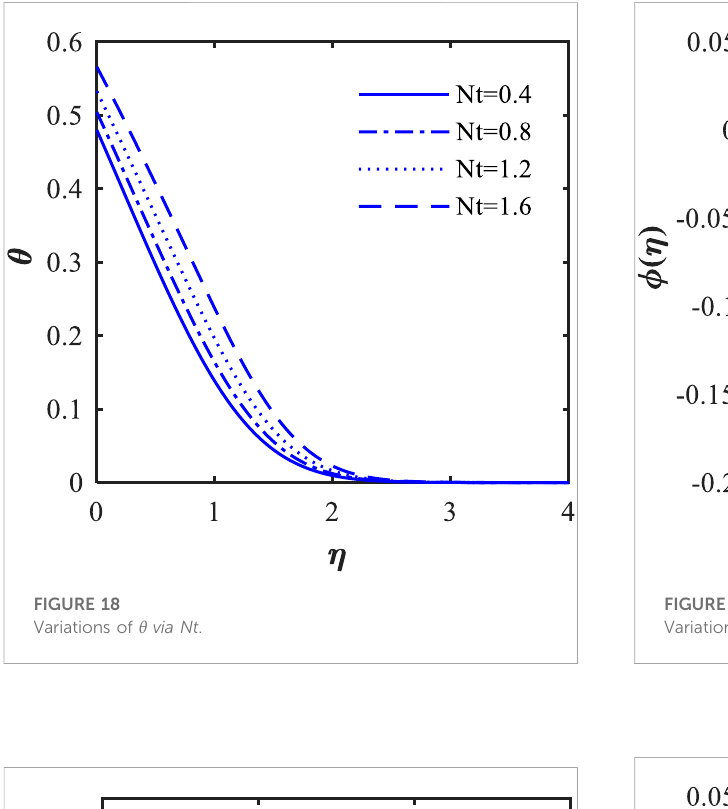
FIGURE 20 Variations of ϕ via Sc .